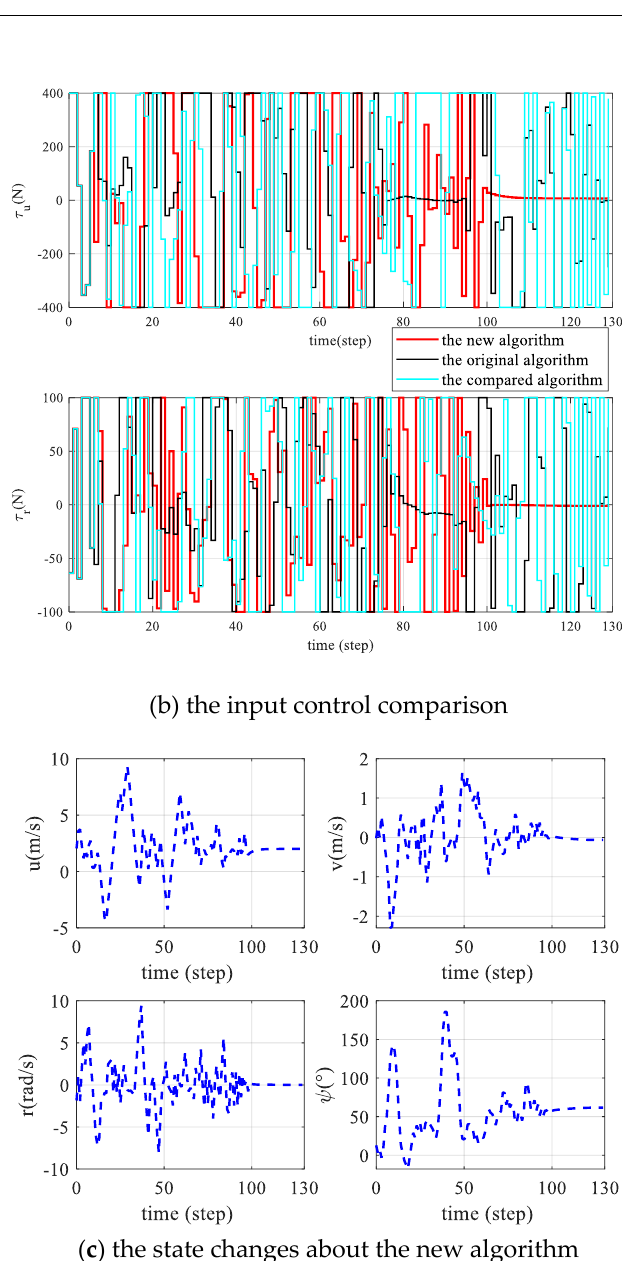
Figure 6. Comparison of algorithms under two obstacle ships.